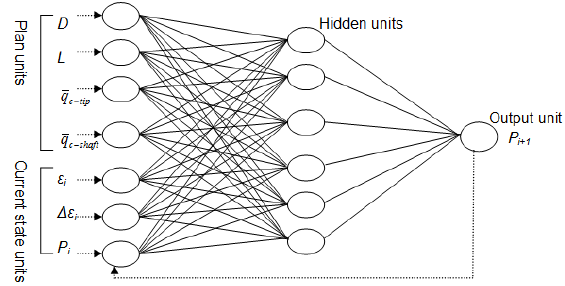
Figure 1. Schematic representation of the structure of ANN model for bored